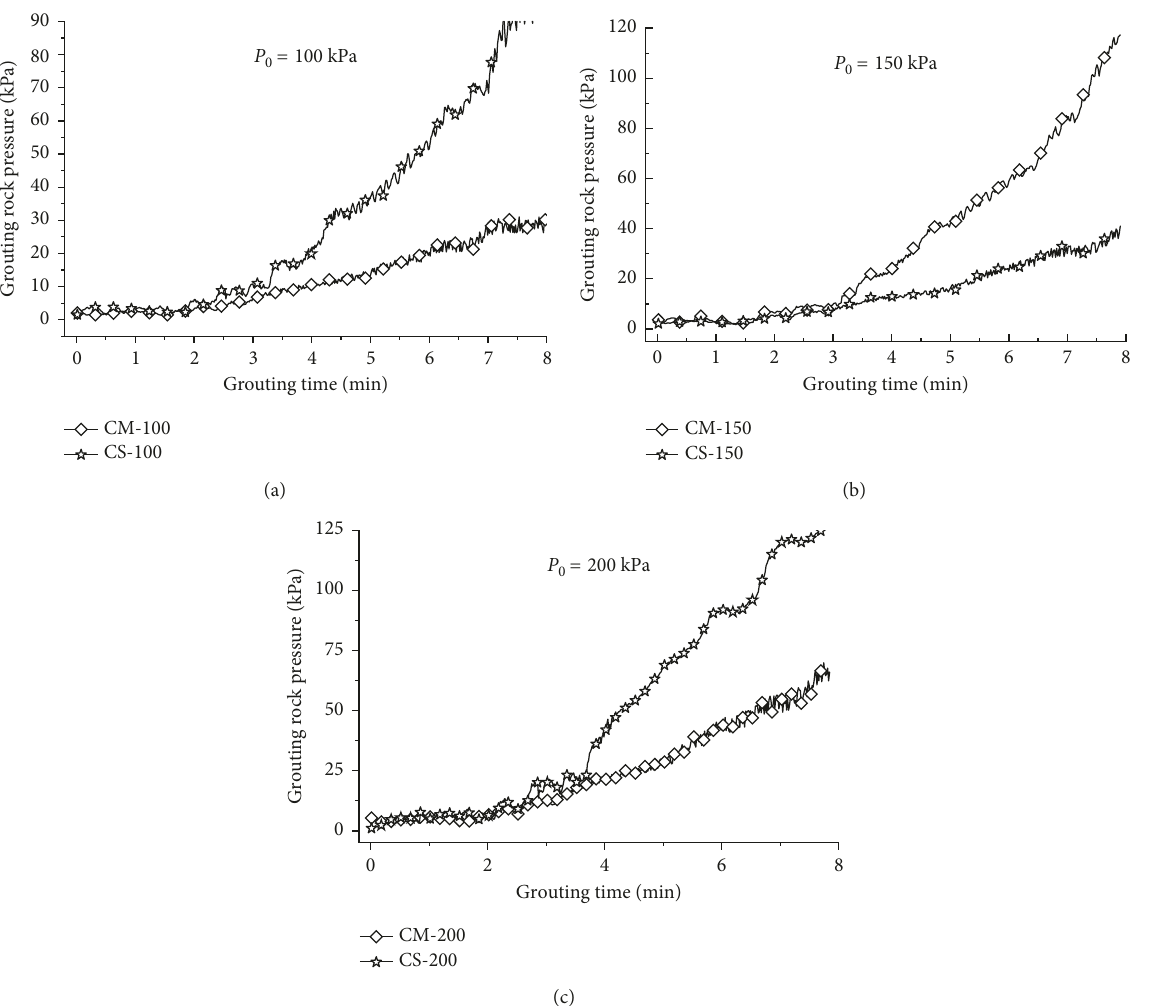
Figure 11: Grouting pressure curves during grouting: (a) initial pressure P pressure P 0 (cid:30)